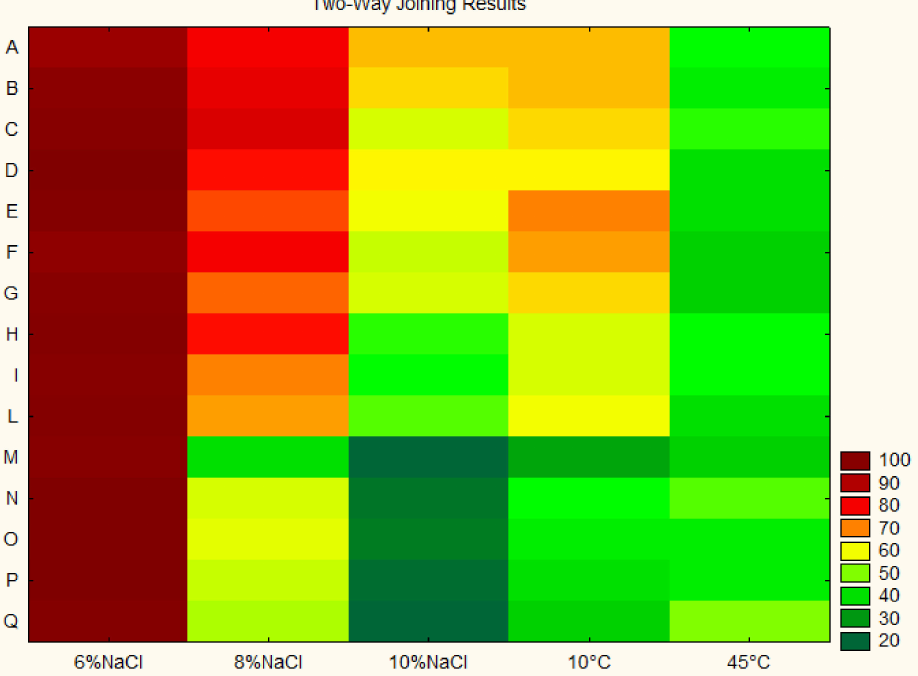
Figure 2. Growth Index at 48 h (%) (median value) of studied strains (134 presumptive lactobacilli ) in MRS broth incubated under stressing conditions (presence of NaCl or temperature of 10 and 45 ◦ C) after 24 h. The input values for two-way joining are in Supplementary Table S1. For the meaning of codes A-Q see Table